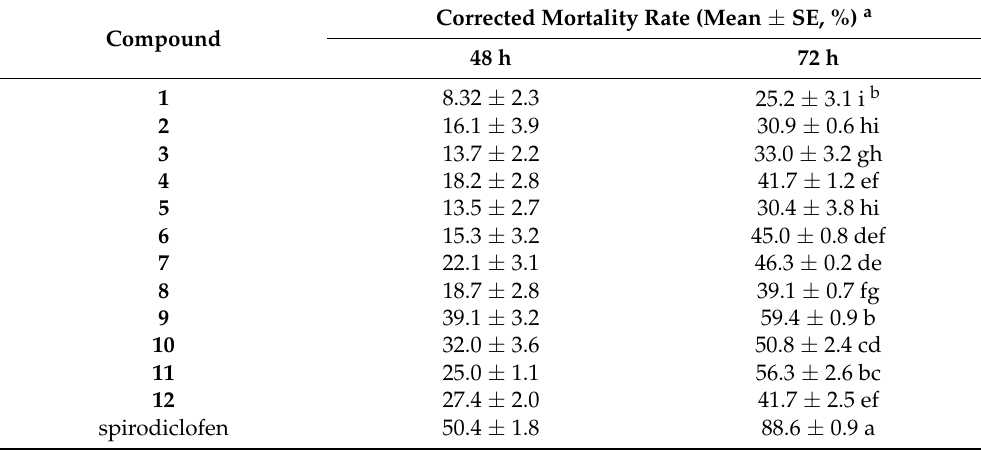
Table 1. Acaricidal activity of compounds 1–12 against female adults of T. cinnabarinus at 0.5 mg/mL. Compound